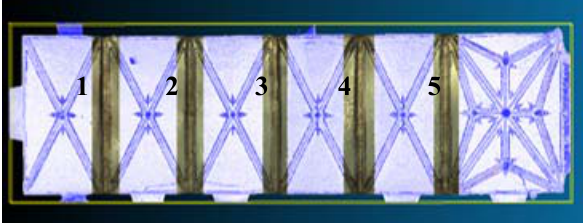
Figure 4: Part of vaulted structure: numbers of archs STAGE 2: During the restoration works, the different stages of